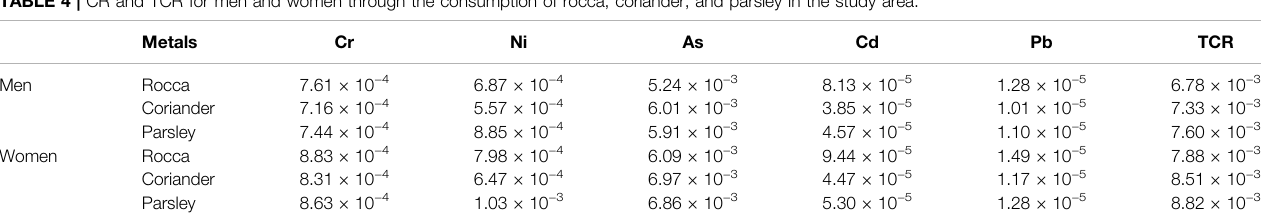
TABLE 4 | CR and TCR for men and women through the consumption of rocca, coriander, and parsley in the study